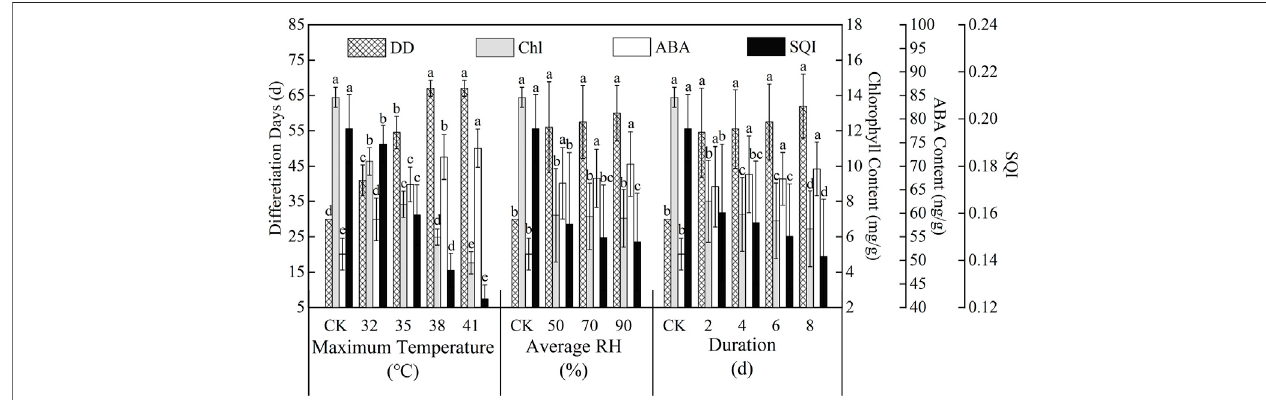
FIGURE 5 | Values of physiological indexes of tomato under different HTHH stress treatments. In the same group, data having the same letters atop bars are not signi fi cantly different determined by Duncan ’ s test ( p ≤ 0.05). The error bars represent standard deviation.